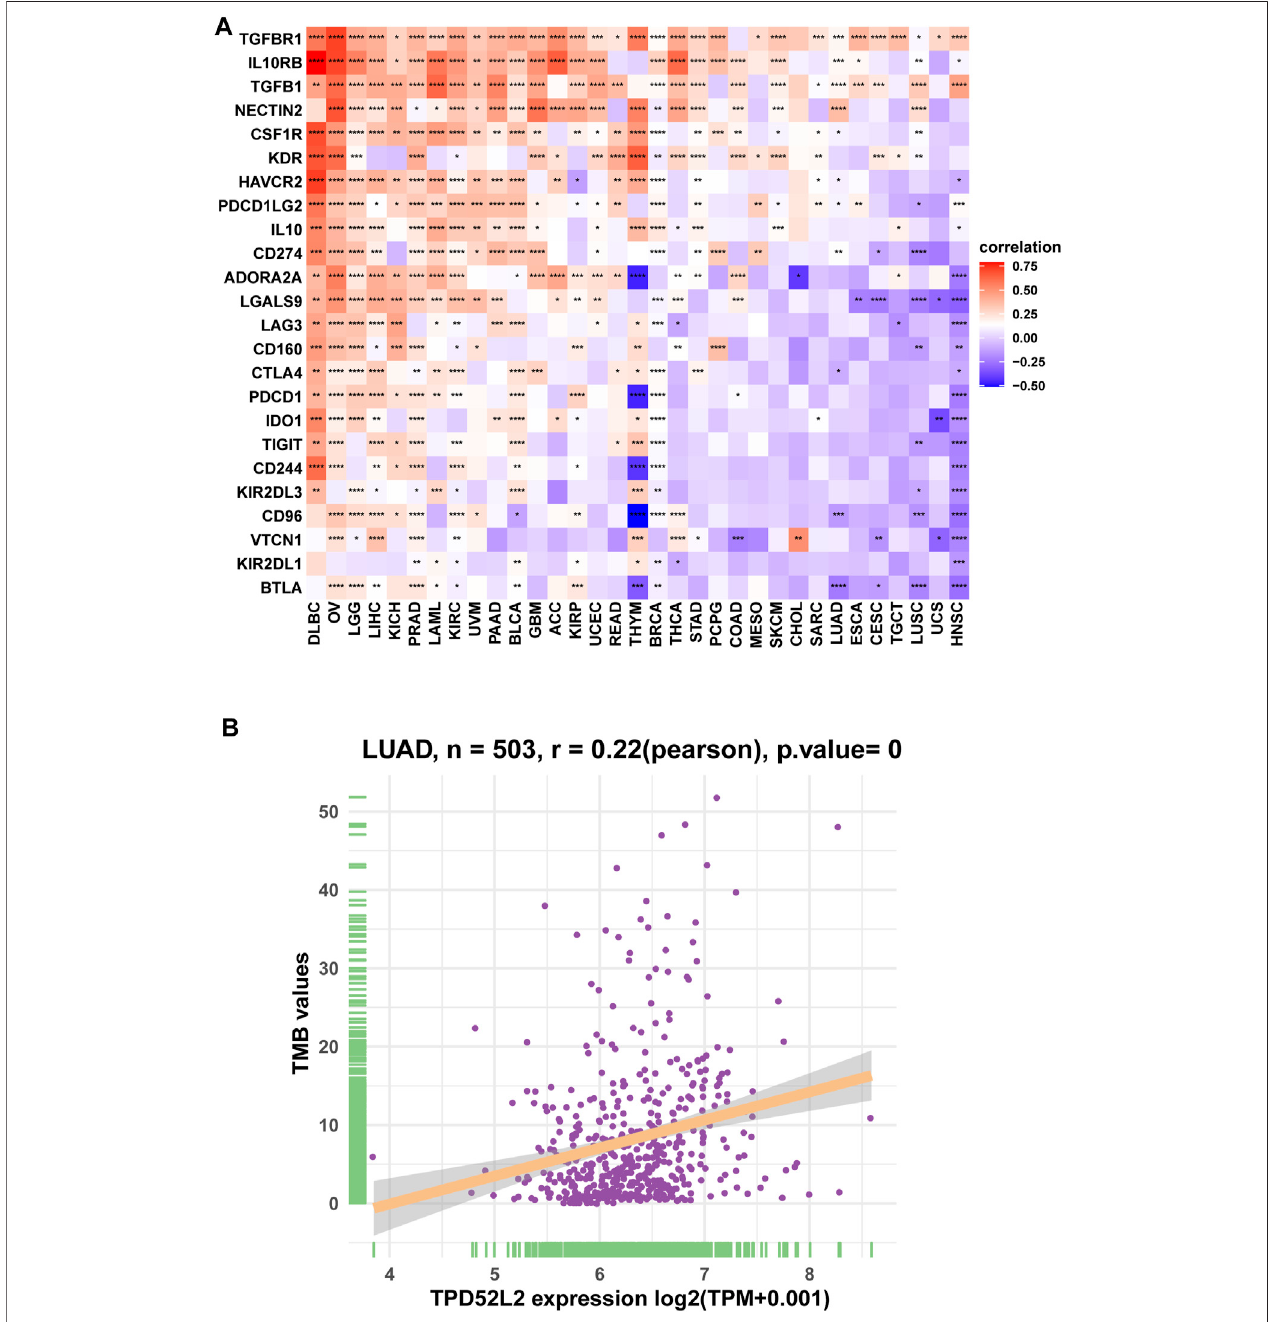
FIGURE 8 | Correlation between immunosuppressive genes. (A) Correlation between TPD52L2 expression and immunosuppressive genes. (B) Correlation between TPD52L2 expression and TMB values. * p < 0.05, ** p < 0.01, *** p < 0.001, and **** p < 0.0001.